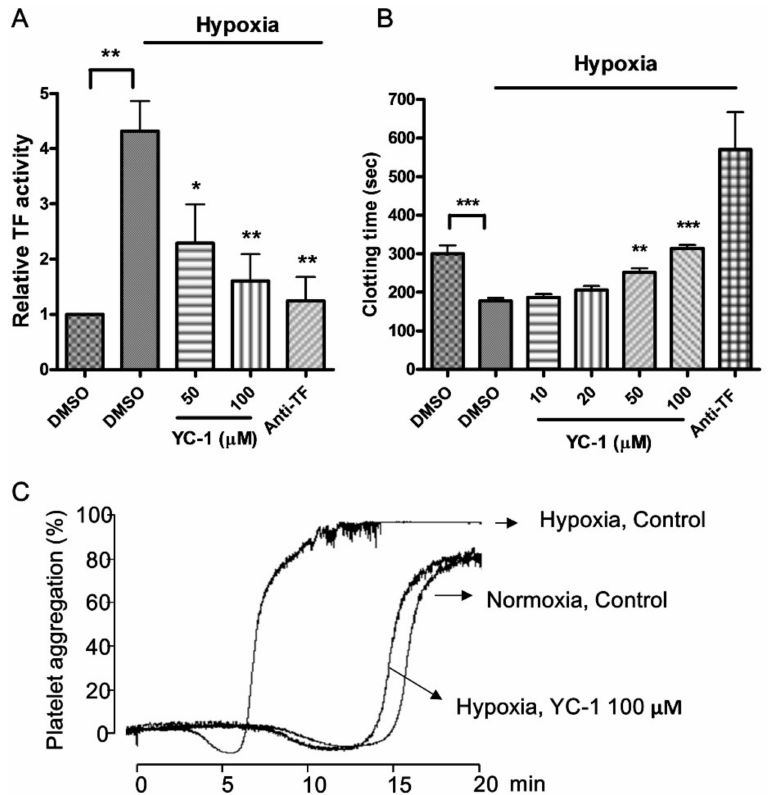
Figure 2. YC-1 reduces hypoxia-induced TF procoagulant activity in A549 cells. A549 cells were pretreated with DMSO or YC-1 for 1 h, and then incubated under hypoxic or normoxic conditions for 24 h. ( A ) The cell surface TF activity was measured by a coupled amidolytic assay of TF-dependent factor Xa generation; ( B ) Cancer cell-induced plasma clotting was determined by tilt tube assay. Anti-TF antibody (20 µ g/mL) was used as positive control. ( C ) A549 cells treated with DMSO or YC-1 (100 µ M) in normoxia or hypoxia were harvested (1 × 10 5 cells/mL) and mixed with platelet suspension (3 × 10 8 platelets/mL). Platelet aggregation was induced by adding human plasma (0.25%). All results are presented as mean ± SEM ( n = 3). * = p < 0.05, ** = p <0.01, *** = p <